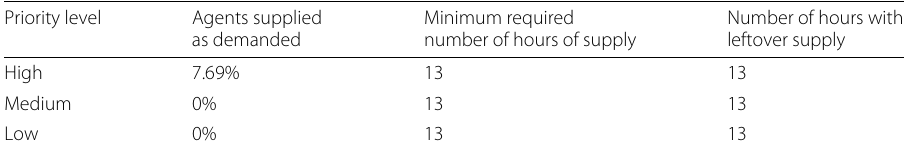
Table 4 Required supply reliability assessment of non-self-sufficient agents - all agents need to be supplied during all the hours with leftover supply